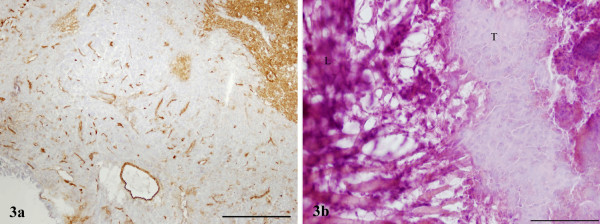
Orthotopic MPM histology. Fig. 3a. Frozen sections of tumors grown into the pleural cavity of nude mice injected with IST-Mes3 cells were stained with an anti-mouse CD31 antibody. Tumors were intensively stained revealing an intricate network of microvessels. Bar = 500 μm. Fig. 3b. H&E staining of tumor invading the lung. T: tumor, L: lung. Bar = 100 μm.